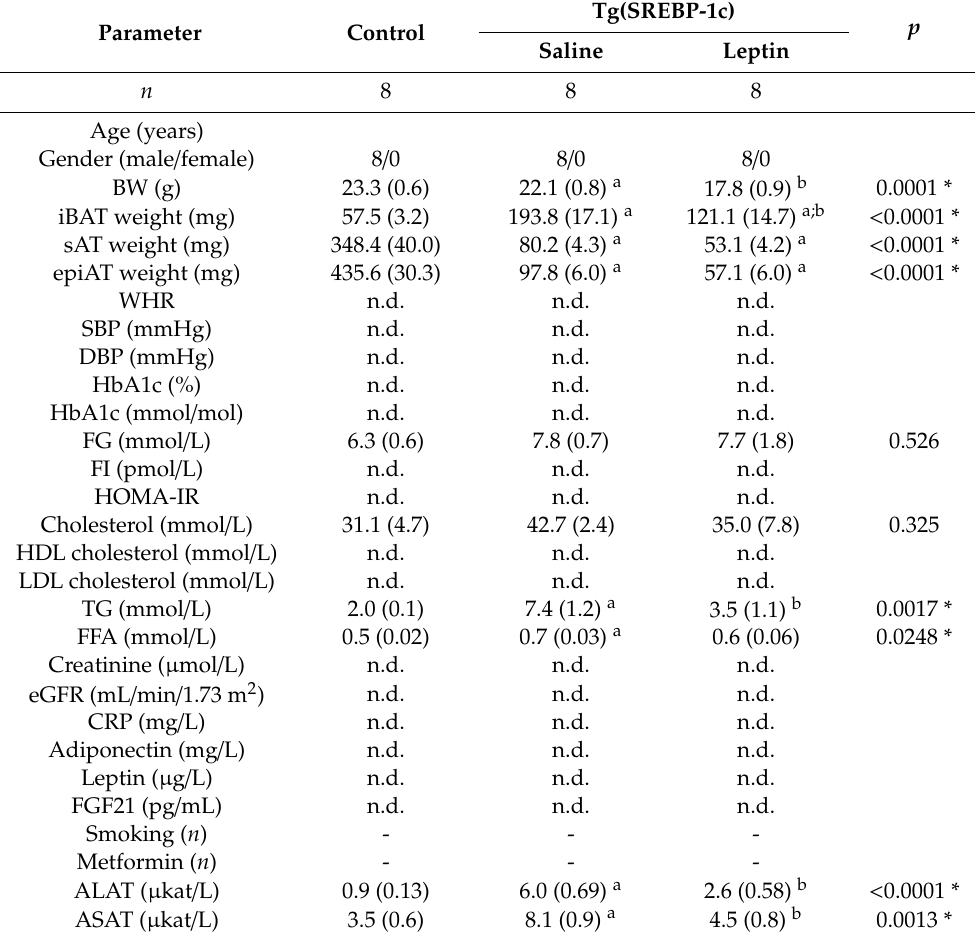
Table 4. Baseline characteristics of the lipodystrophic animal setting ( n = 8 per